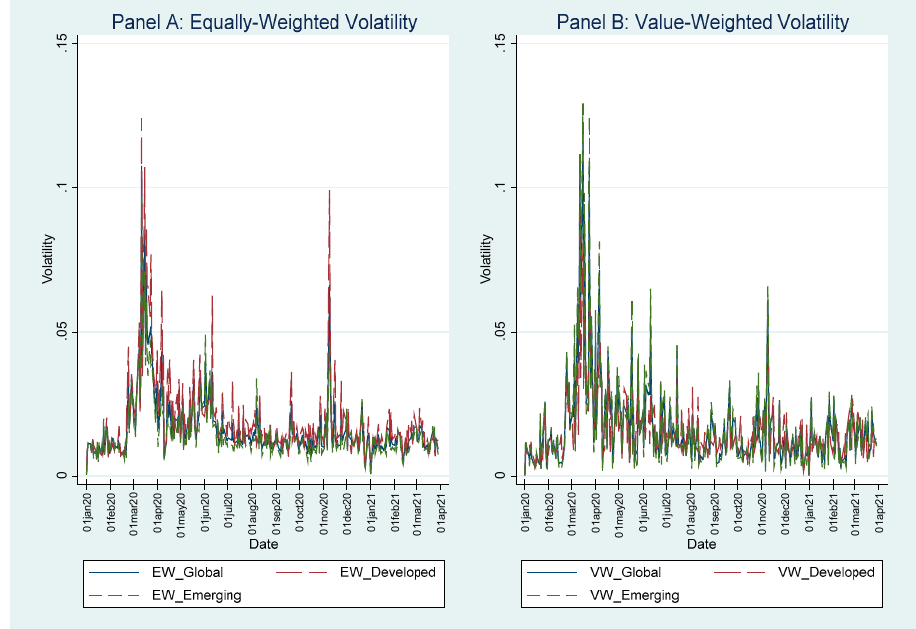
Figure 1. Volatility in international markets during the COVID-19 pandemic. The figure presents the average daily absolute returns on investment in travel and leisure stocks across countries covered. The presented measures of volatility are for the whole sample (solid blue line), the sub-sample of developed countries (long-dashed red line) and the sub-sample of emerging markets (dashed green line). The research period is from 1 January 2020 to 30 March 2021. Panels A and B report equal-weighted averages and value-weighted averages, respectively.